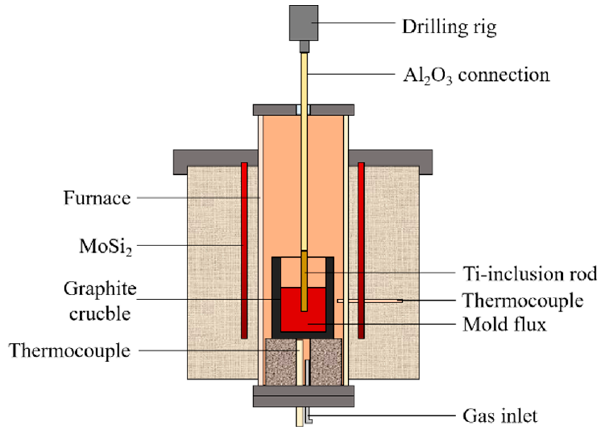
Figure 1. Schematic diagram of the experimental apparatus.